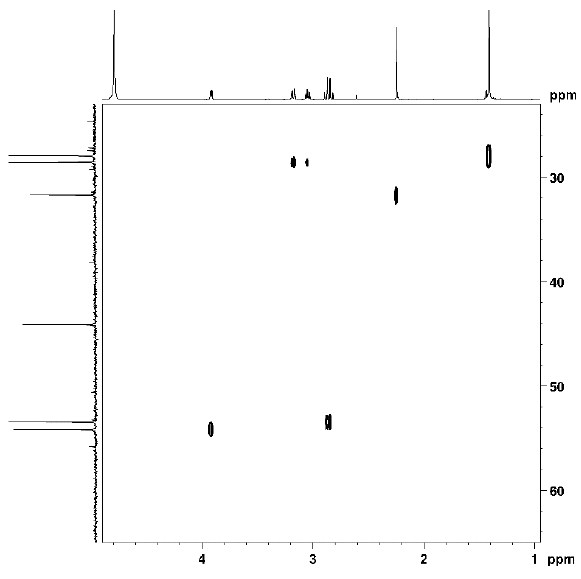
Figure 2. 1 H- 13 C HSQC NMR spectrum of cysteine monoadduct 3 (cys-4MMP).